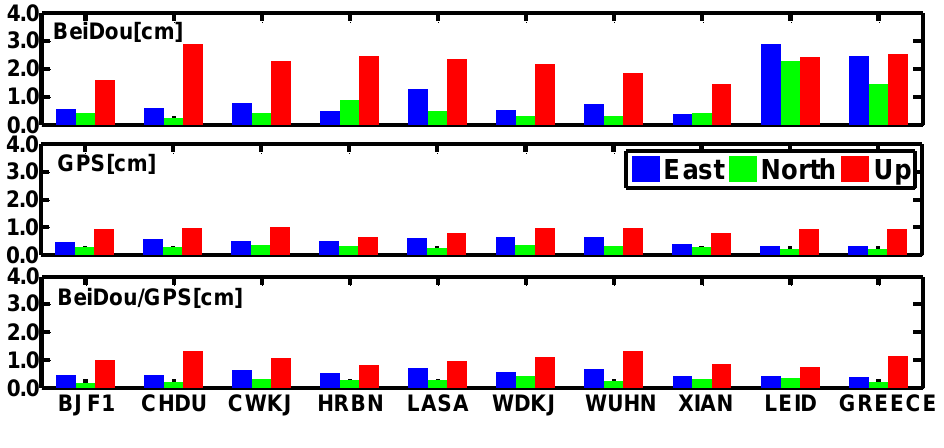
Figure 7. RMS values of the differences between the BeiDou, GPS, and BeiDou/GPS static PPP results and the “ground truth” in the East, North and Up components from September 4 to September 30 in